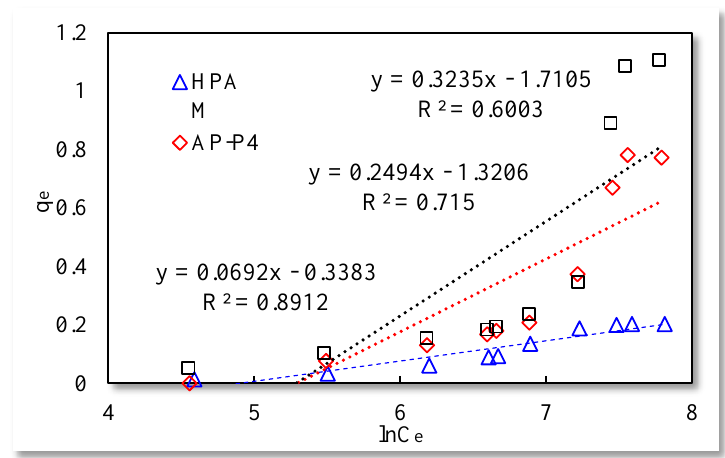
Figure 5. Temkin isothermal adsorption model.